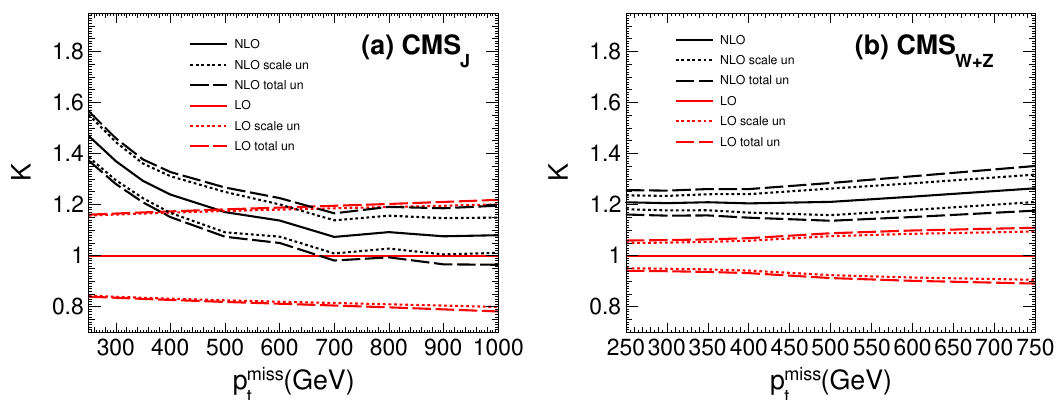
Figure 6. K-factors defined as ratio of NLO cross sections to LO cross sections for inclusive regions as a function of the lower threshold for CMS mono-jet and mono- W/Z on the left and right respectively, for a Z 0 mass of 1 TeV. The dashed (dotted) lines show the total (scale) uncertainties of the LO and NLO